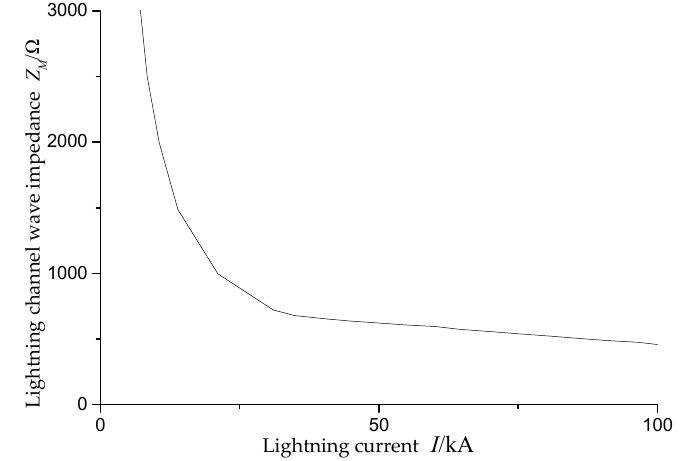
Figure 6. Integrated wave impedance model of offshore WT considering Z M .